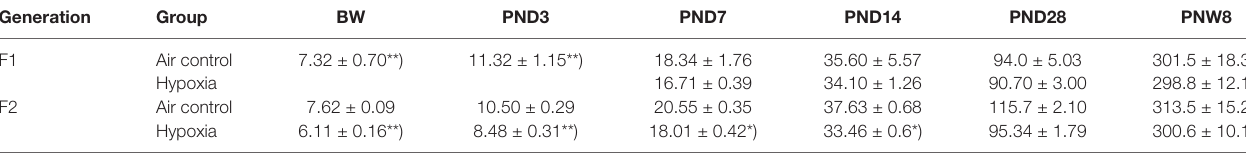
TABlE 1 | The intrauterine hypoxia effect on F1 and F2 generation’s weight after birth ( ̄ x ± s , g , n = 15). Generation Group BW PND3 PND7 PND14 F1 Air control